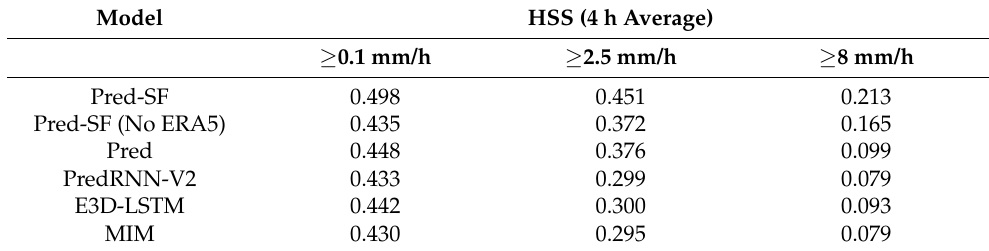
Table 4. HSS indicators of three groups of different models.